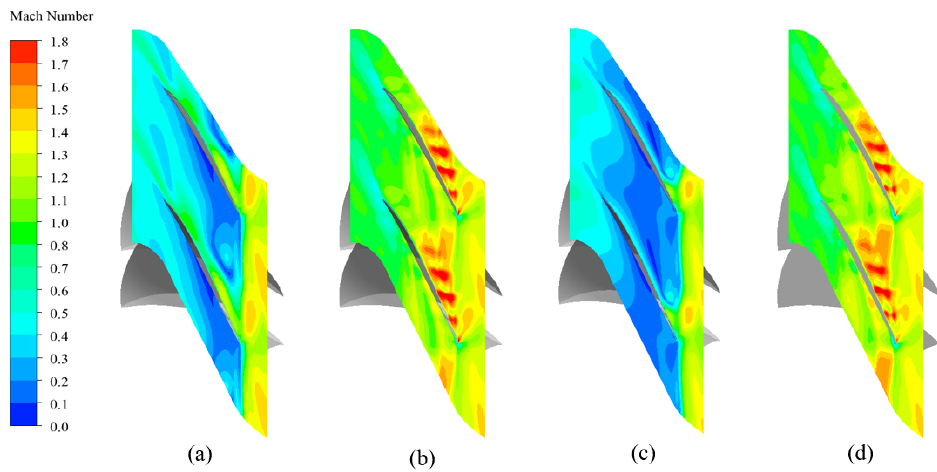
Figure 7. Contours of Mach number at 98% span. ( a ) ORI; ( b ) SES; ( c ) SEI; ( d ) CCT.